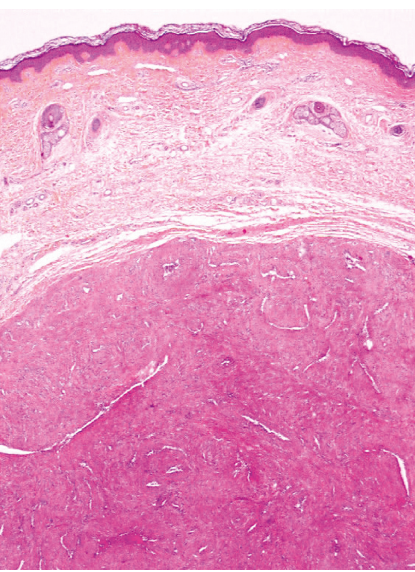
Figure 1: A well-demarcated nodule is seen in the dermis (original magnification: × 40).